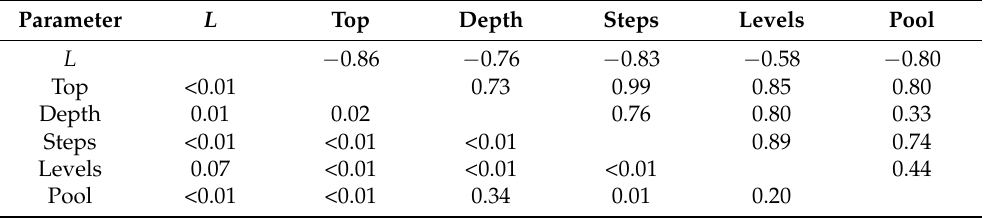
Table A2. Correlation matrix for the reflected energy level ( L , in decibels) and the logarithm of the architectural parameters (top area, depth in steps, total number of steps, number of levels, pool area). The top right of the table shows pairwise linear correlation coefficients. The bottom left of the table shows p